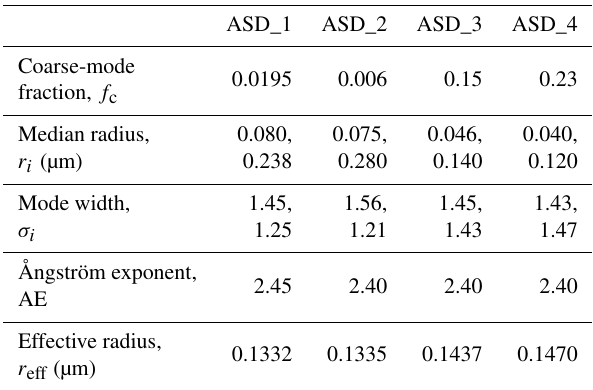
Table A1. Four BD fits to OPC data measured at Laramie, Wyoming, on 12 April 2010 at 20km.